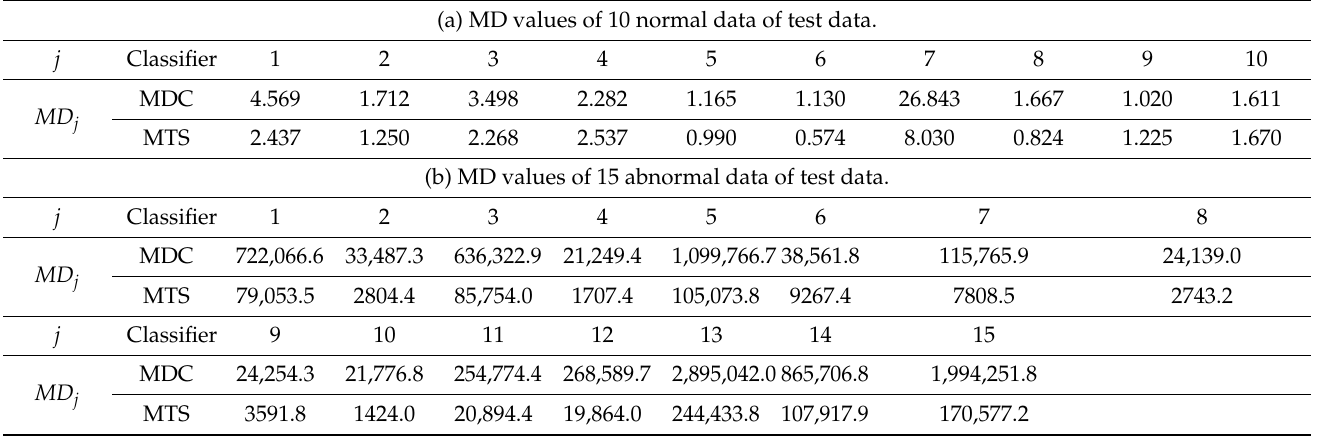
Table 9. Mahalanobis distances of test data. (a) MD values of 10 normal data of test data.